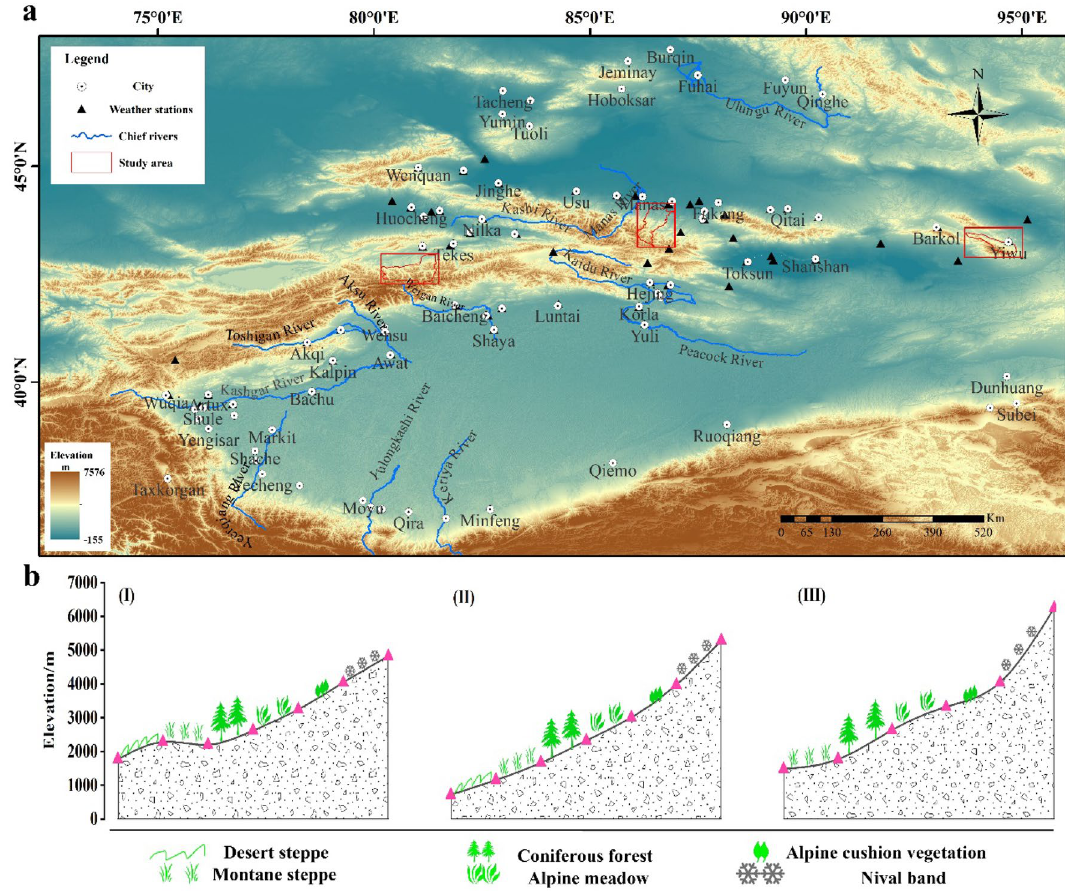
Figure 1. Location of the study area and the composition of the altitudinal vegetation belts. ( a ) The areas enclosed by the red rectangles are our study area. The rectangle on the left is Zhaosu county; the middle is Hutubi county; and the right is Yiwu county. ( b ) The altitudinal vegetation belts in Tianshan Mountains; (I), (II), and (III) indicate Yiwu county, Hutubi county, and Zhaosu county,